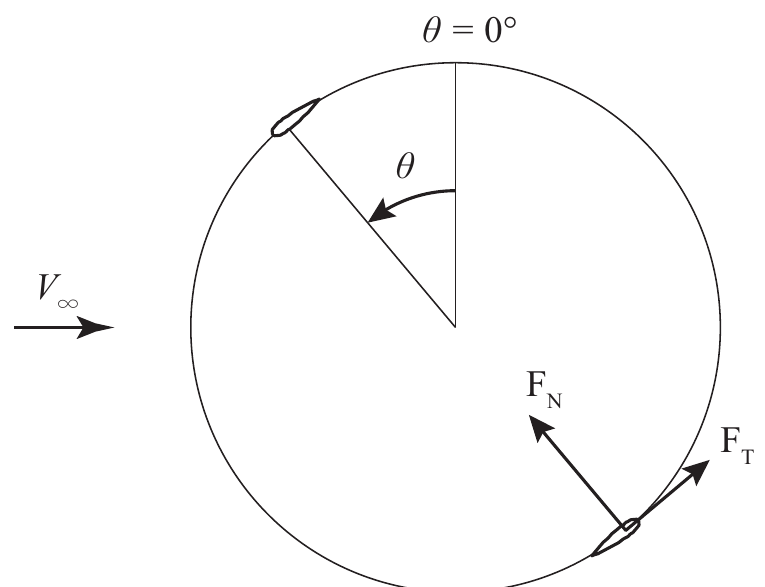
Figure 6. Sign convention of the forces and the definition of the rotor azimuth